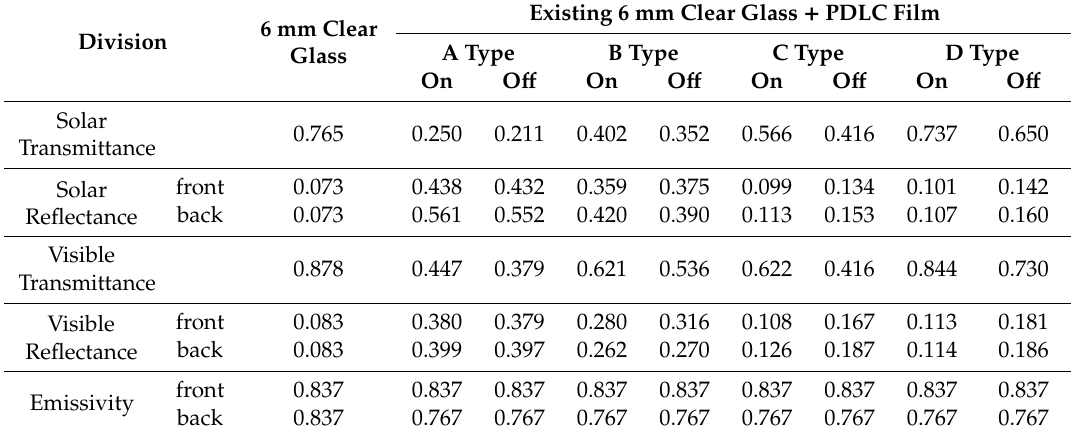
Table 4. Optical properties of single glazing with a PDLC film.